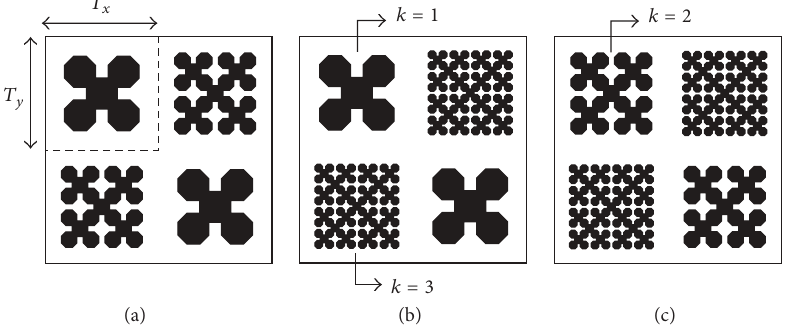
Figure 2: Illustrations of the proposed FSS geometries composed of dissimilar Sierpinski patch elements corresponding to the integration of (a) 𝑘 = 1 and 𝑘 = 2 , (b) 𝑘 = 1 and 𝑘 = 3 , and (c) 𝑘 = 2 and 𝑘 = 3 fractal level